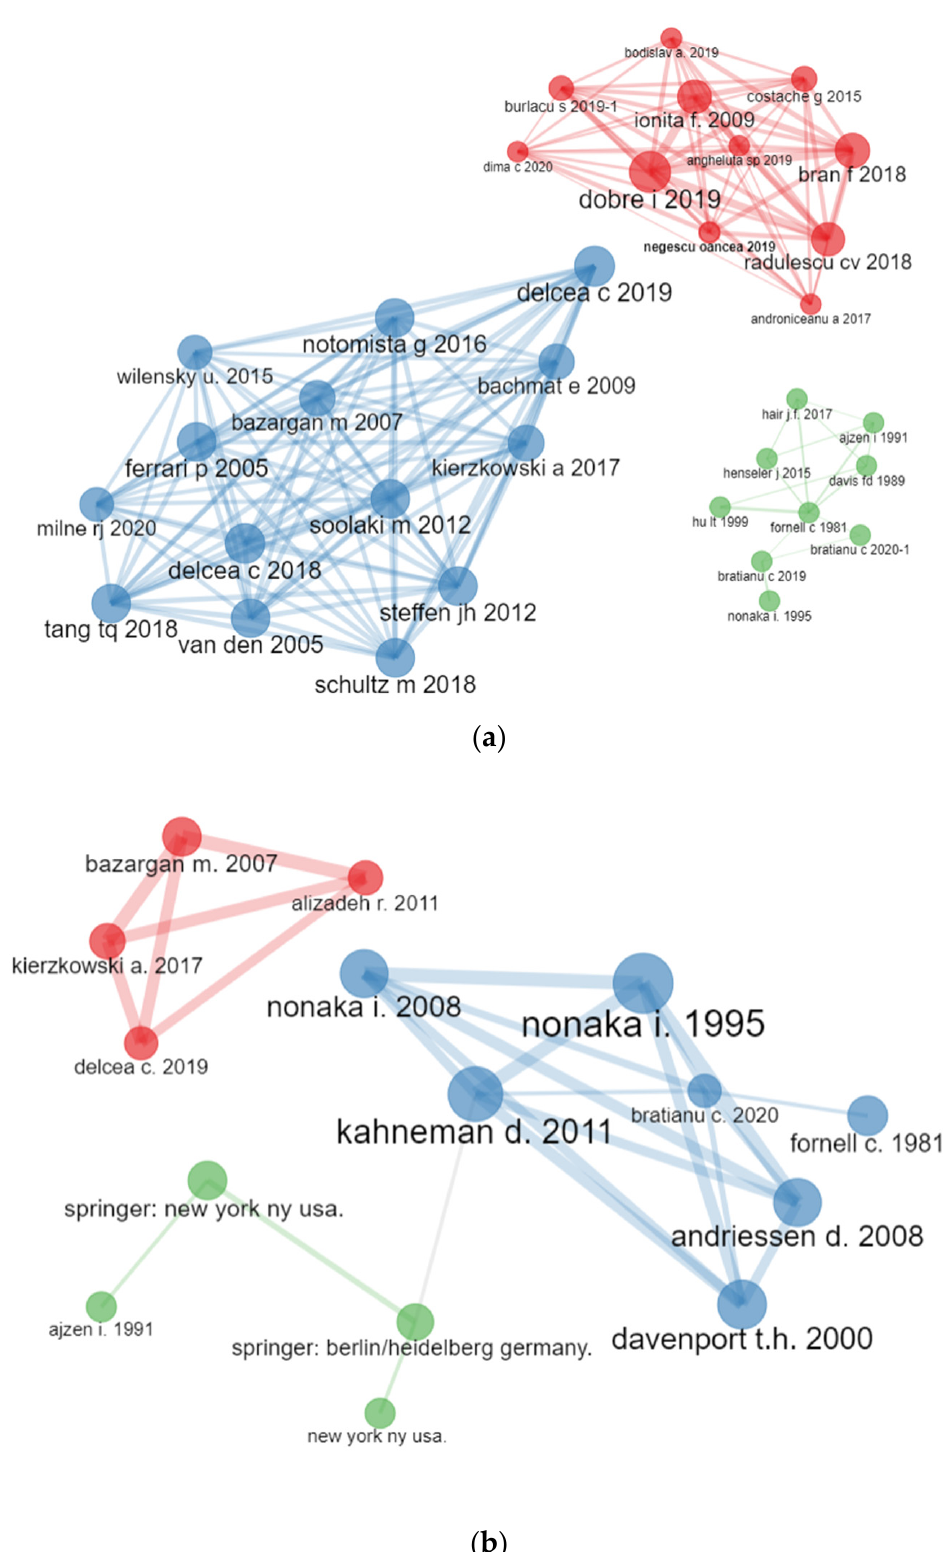
Figure 14. Co-citation network analysis on paper. ( a ) WoS. ( b ) Scopus.